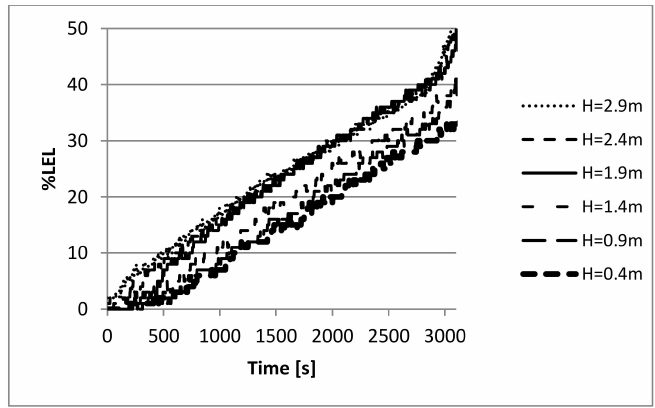
Figure 5. Hydrogen condensation range in the Test 2.